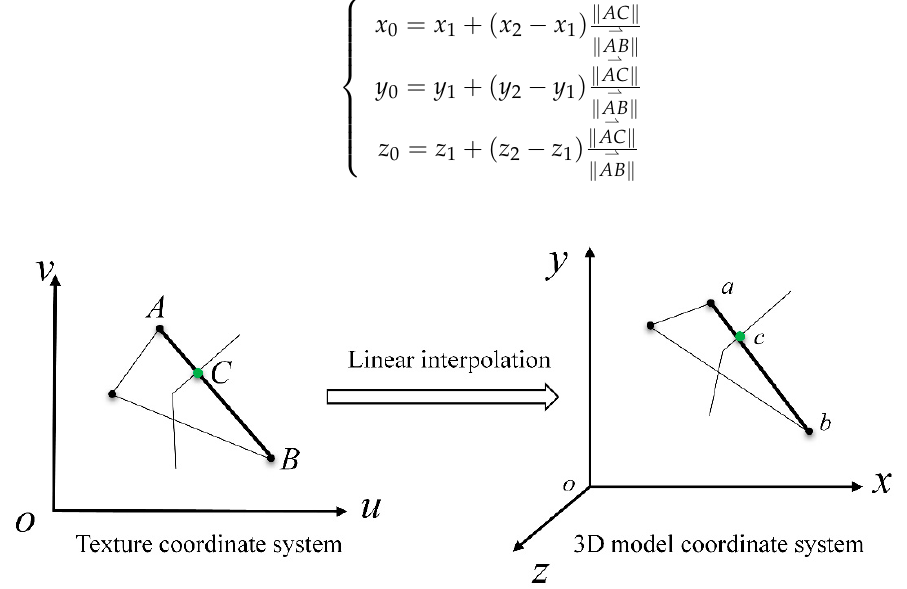
Figure 7. The idea of the method to calculate 3D coordinates of intersections using linear interpolation.